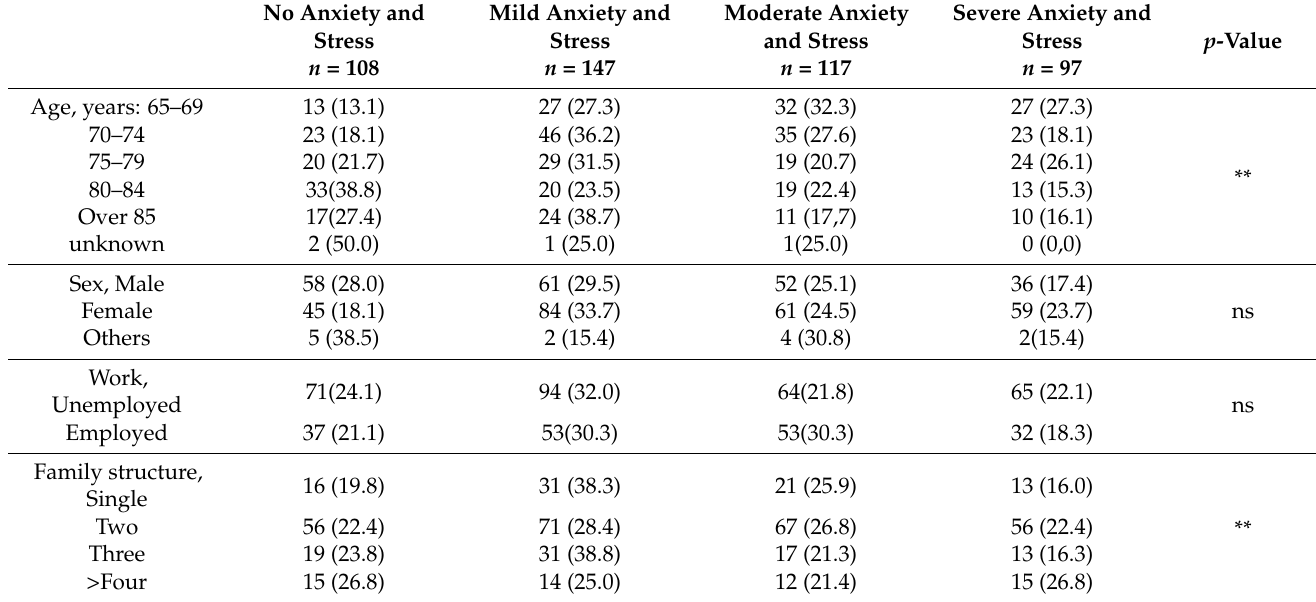
Table 5. Age, sex, employment, and family structure during the COVID-19 pandemic in respondent groups with different levels of anxiety and